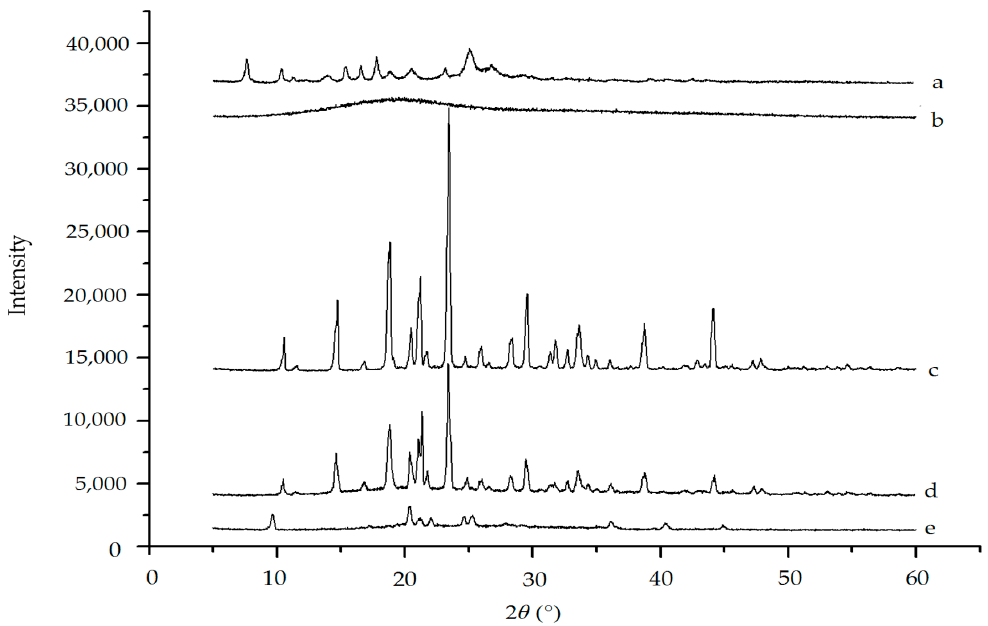
Figure 7. XRPD spectrum of ( a ) raw vitexin; ( b ) poloxamer 188; ( c ) mannitol; ( d ) physical mixture; and ( e ) vitexin nanoparticles.